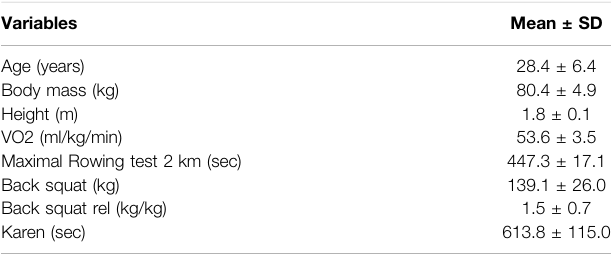
TABLE 1 | Baseline sample demographics and performance characteristics ( n =